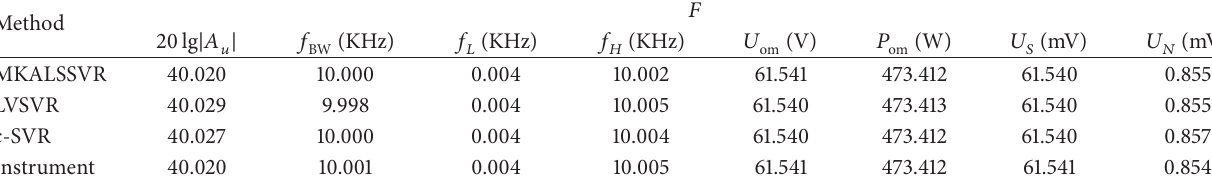
Figure 3: Local regression curve of output 𝑈 𝑂 and gain 20 lg |𝐴 𝑢 | with the three methods. Table 2: Result of comparative